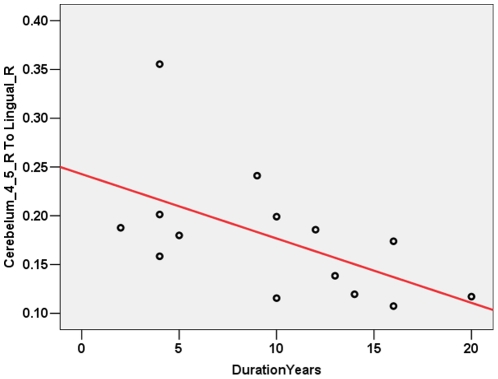
Tendency of correlation between connectivity and clinical measurements.The connectivity between AAL regions Cerebelum_4_5_R and Lingual_R was found to be negatively correlated to the years of illness duration across patients.